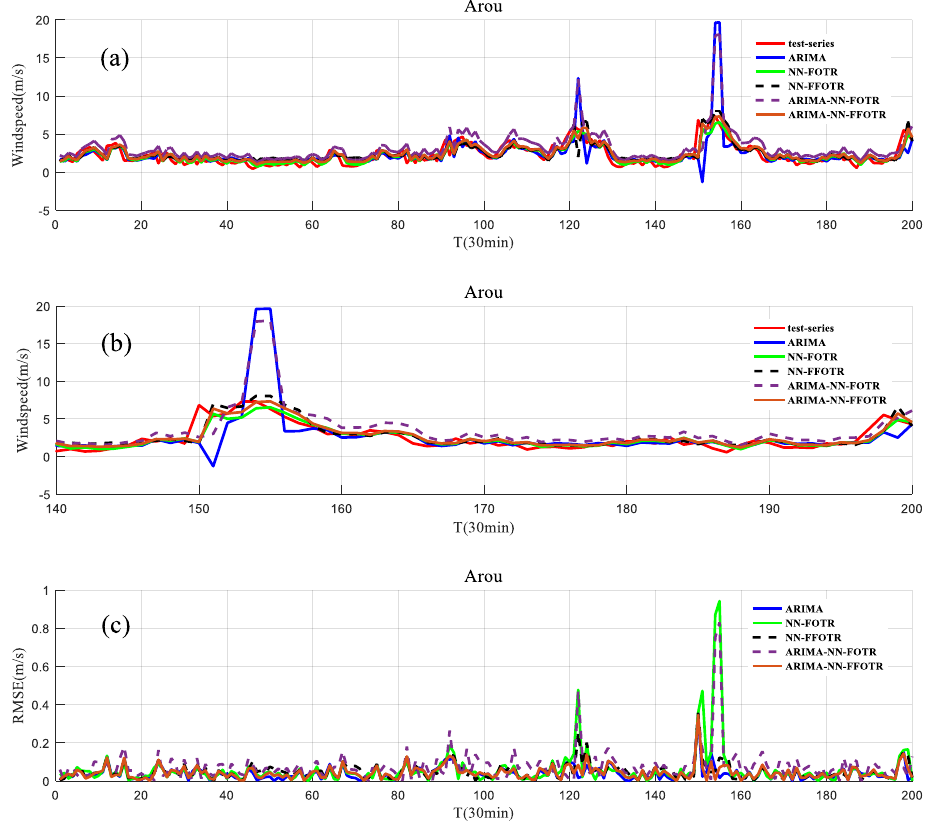
Figure 10. Results of the predictions for the wind speed at the Yakou site. ( a ) Overall, ( b ) local enlargement, ( c ) RMSEs for the wind speed at the Yakou site.